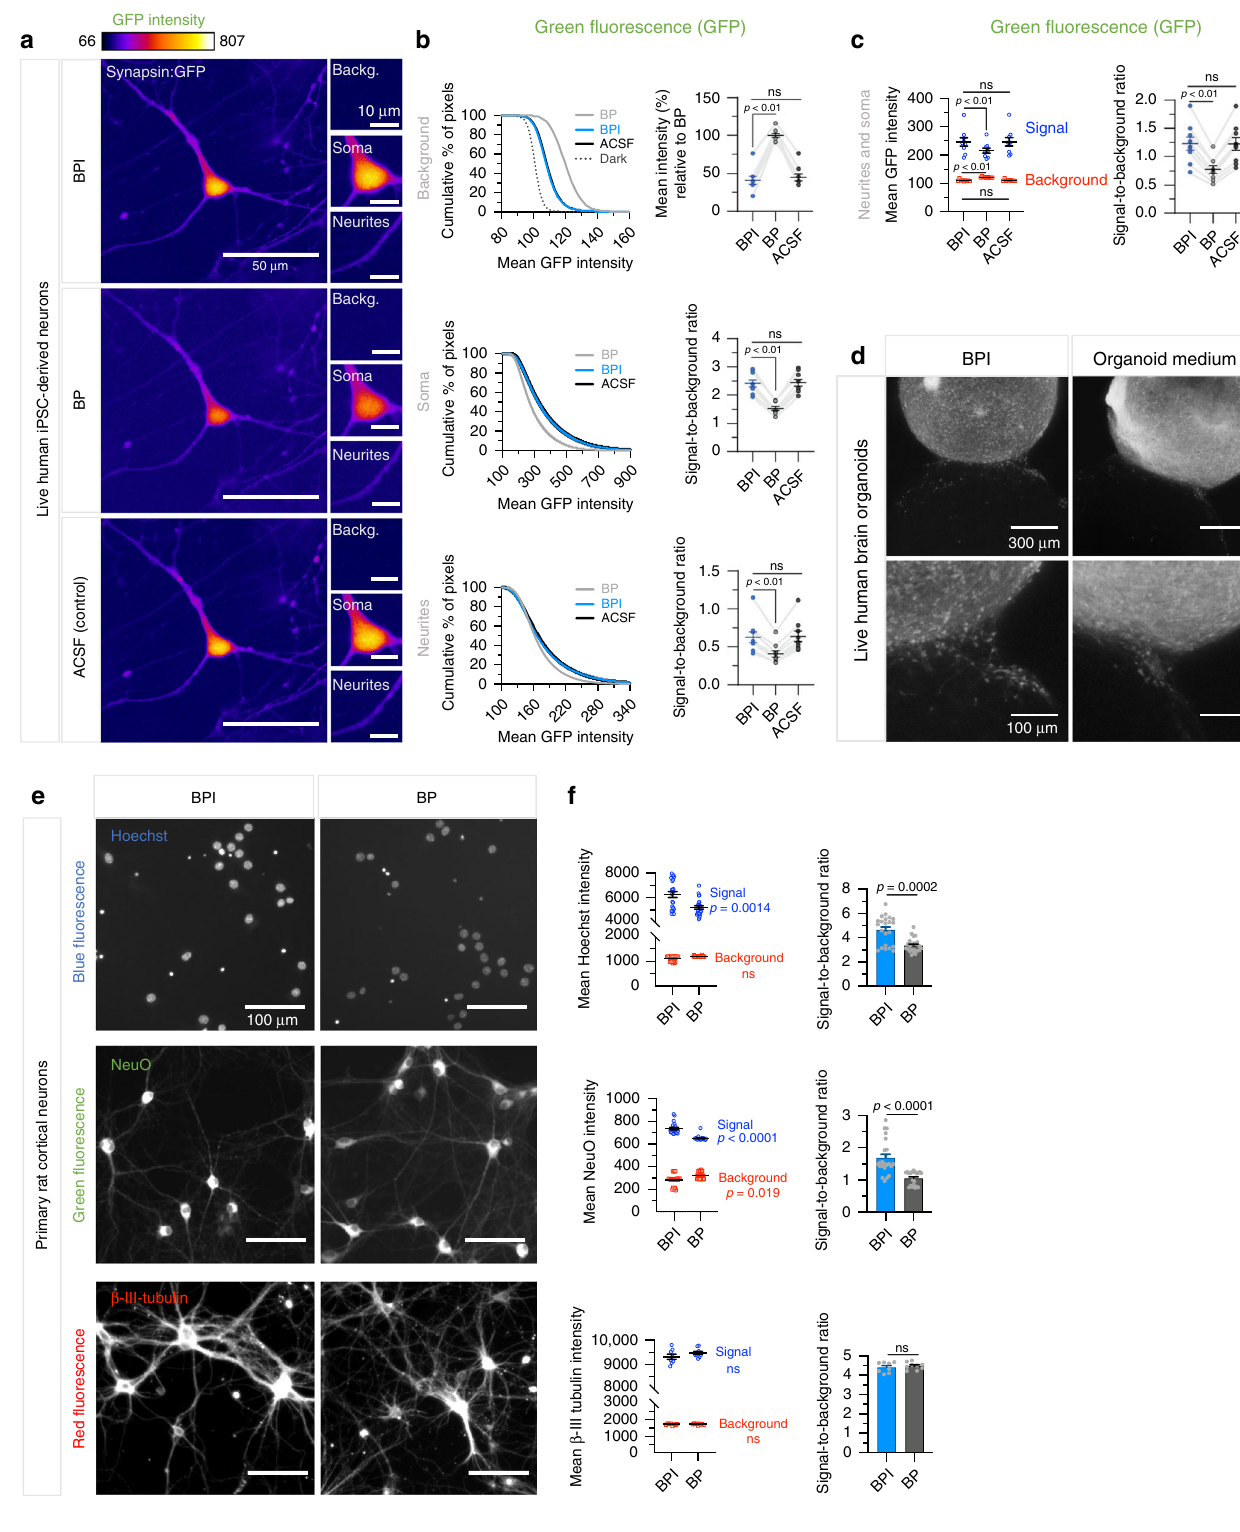
allowed for better visualization of migrating neurons than in standard organoid maturation medium (Fig. 2d). We then used rat cortical primary neurons to test the signal-to-background ratio at different wavelengths. The primary neurons were either fi xed and labeled in red with β -III-tubulin and DyLight ™ 594 (excitation/emission at 593/618 nm) or live in green with the neuron-speci fi c dye NeuroFluor ™ NeuO (excitation/emission at